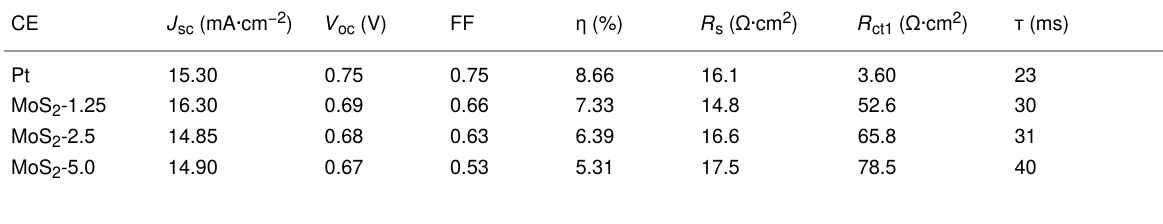
Table 2: Photovoltaic parameters and EIS data of the DSSCs based on different MoS 2 CEs and a Pt CE. CE